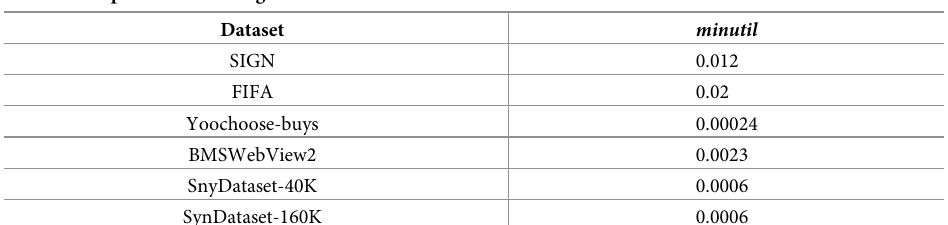
Fig 7. Utility incremental with I 1 = 0.01. (a) SIGN, (b) FIFA, (c) Yoochoose-buys, (d) BMSWebView2, (e) SynDataset-40K, and (f) SynDataset-160K. https://doi.org/10.1371/journal.pone.0283365.g007 Table 5. The parameters